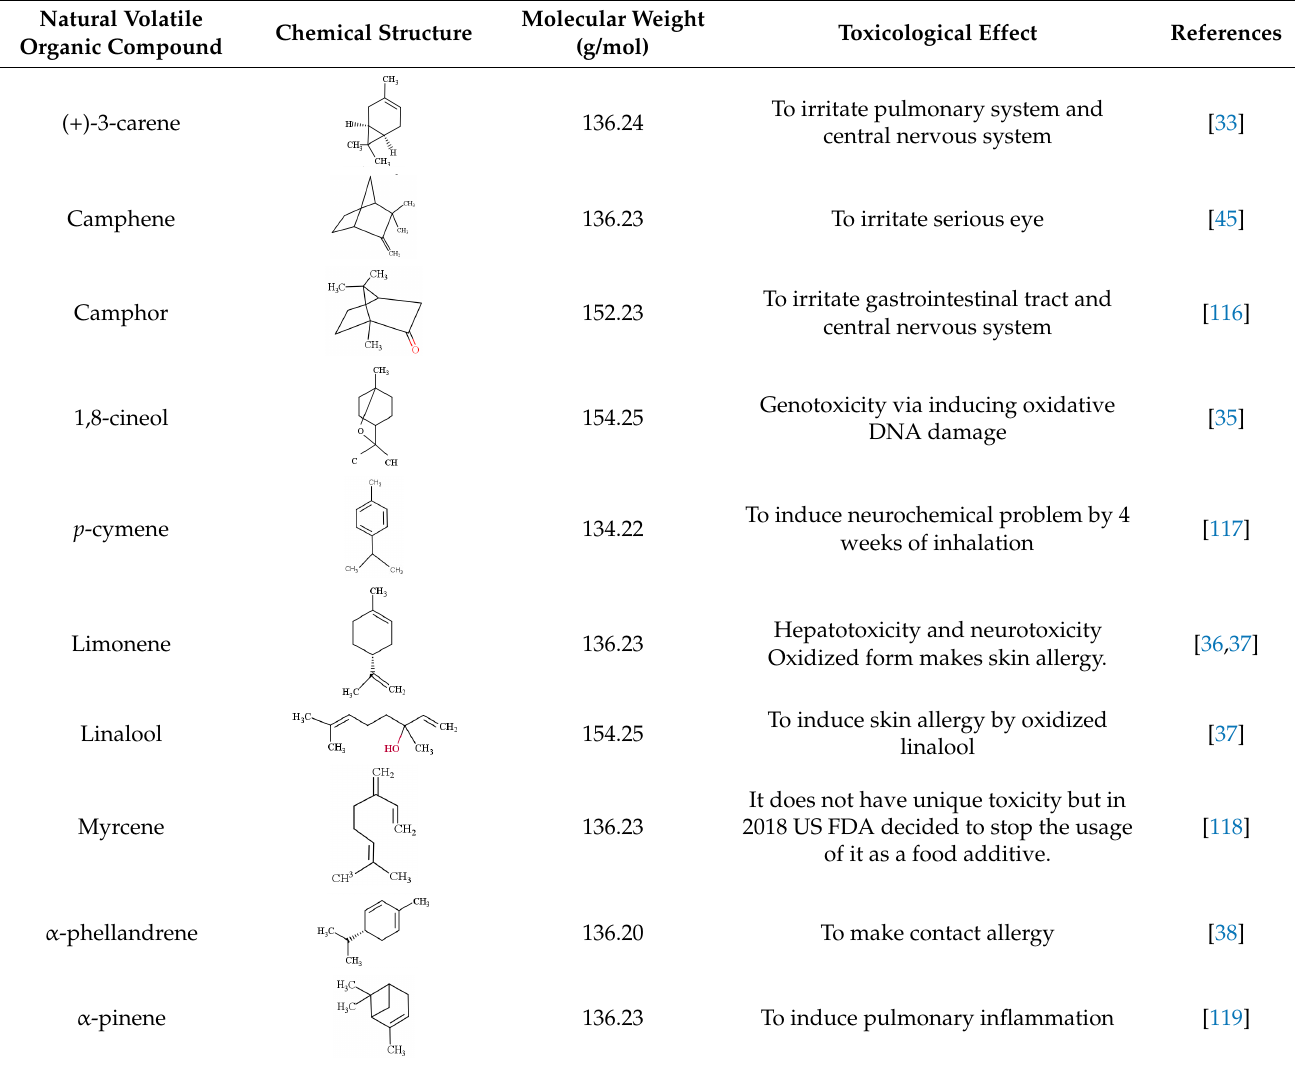
Table 1. Toxicological effects of natural volatile organic compounds (NVOCs).